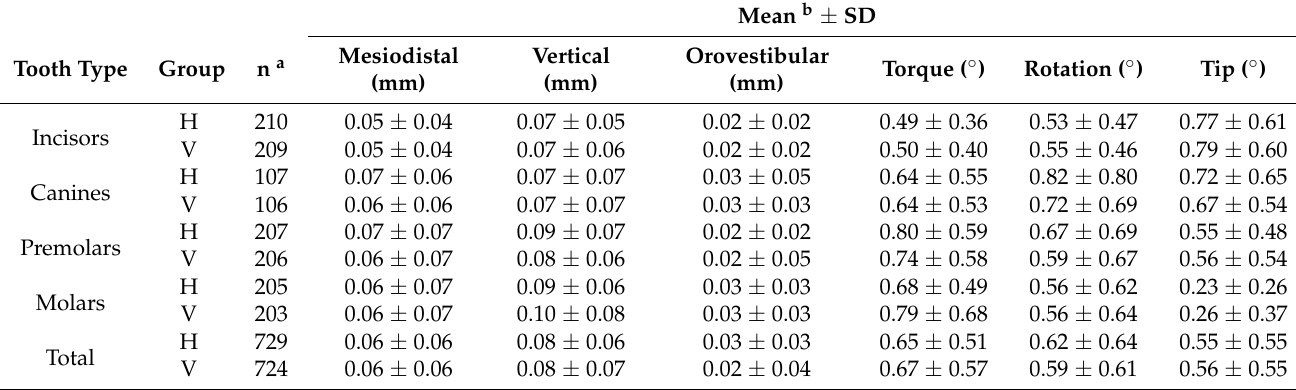
Table 2. Differences between pre- and post-bonding positions in Group H and V for different tooth